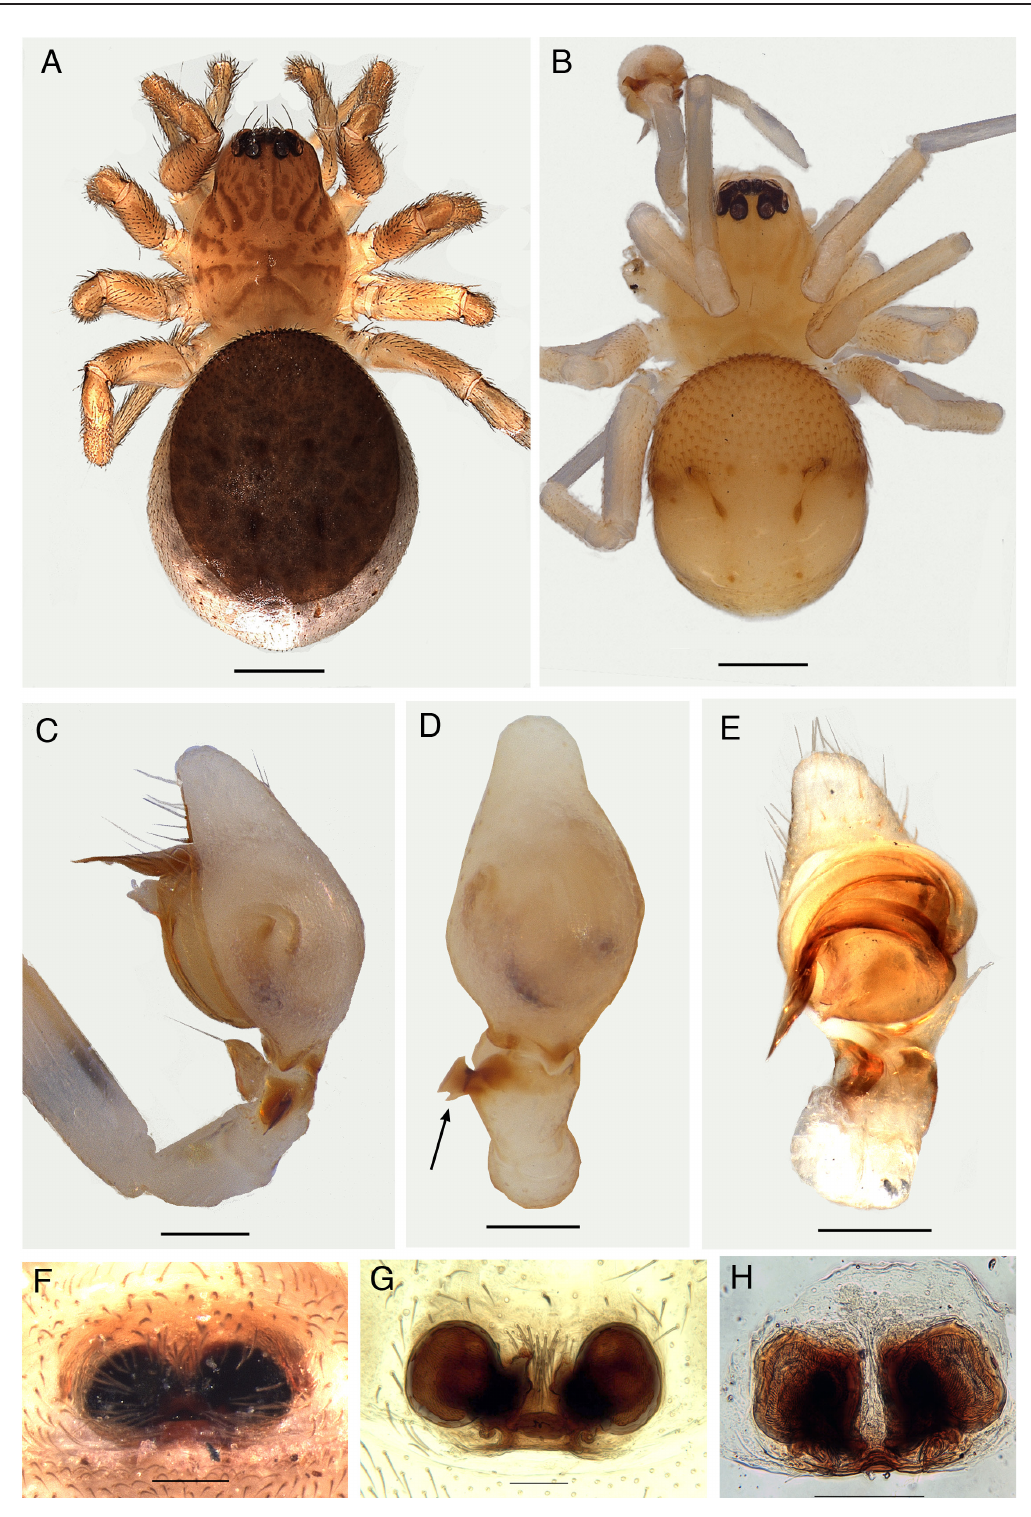
Fig. 7. Chumma striata sp. nov. A , F , G . Holotype, ♀. B , E . ♂ (MRAC 169642). C , D . ♂ (MRAC 169733). A . Habitus, dorsal view. B . Habitus, dorsal view. C . Palp, retrolateral view. D . As preceding, dorsal view (arrow indicates posterior spine on RTA). E . As preceding, ventral view. F . Epigyne, ventral view. G . Epigyne, cleared, dorsal view. – H . Chumma gastroperforata Jocqué, 2001, paratype, ♀ (MRAC 131718), epigyne. Scale bars: A–B = 0.5 mm; C–E = 0.2 mm, E–H = 0.1